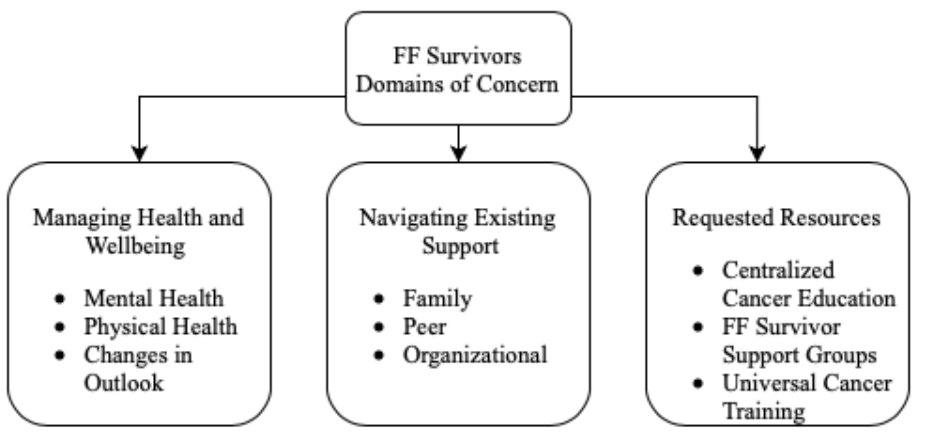
Figure 1. Themes and subthemes evidenced in focus